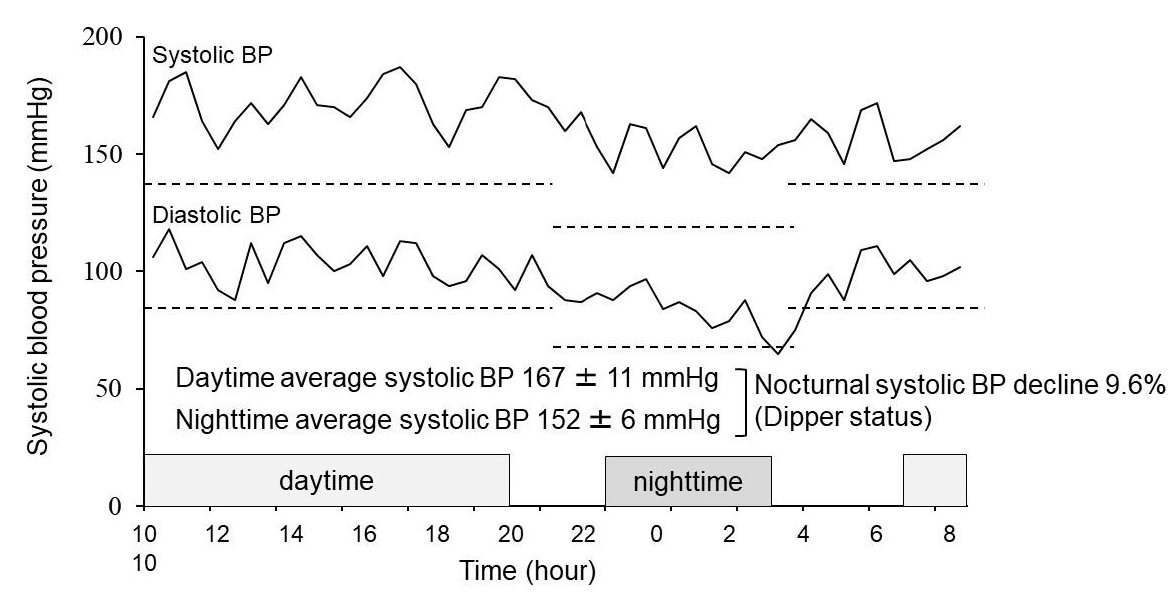
Figure 2. A representative patient with non-dipper status. A 54-year-old woman with non-dipper status with a nocturnal systolic blood pres-